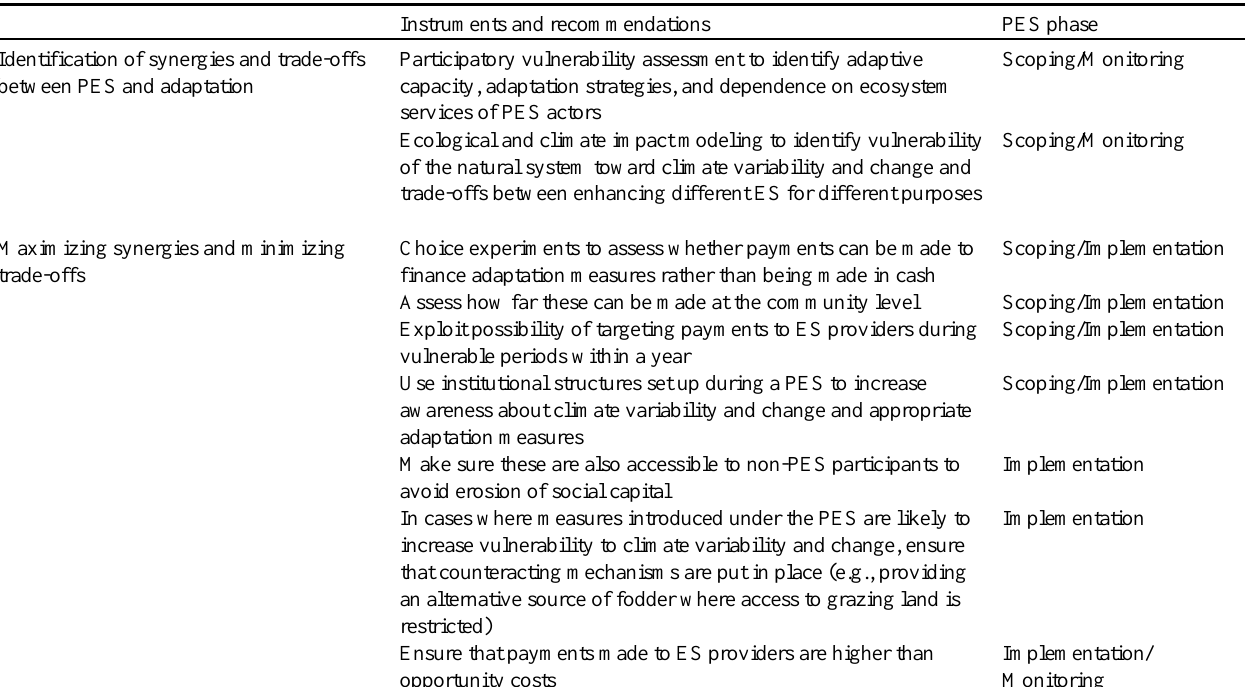
Table 1 . Instruments and recommendations for making PES pro-poor and